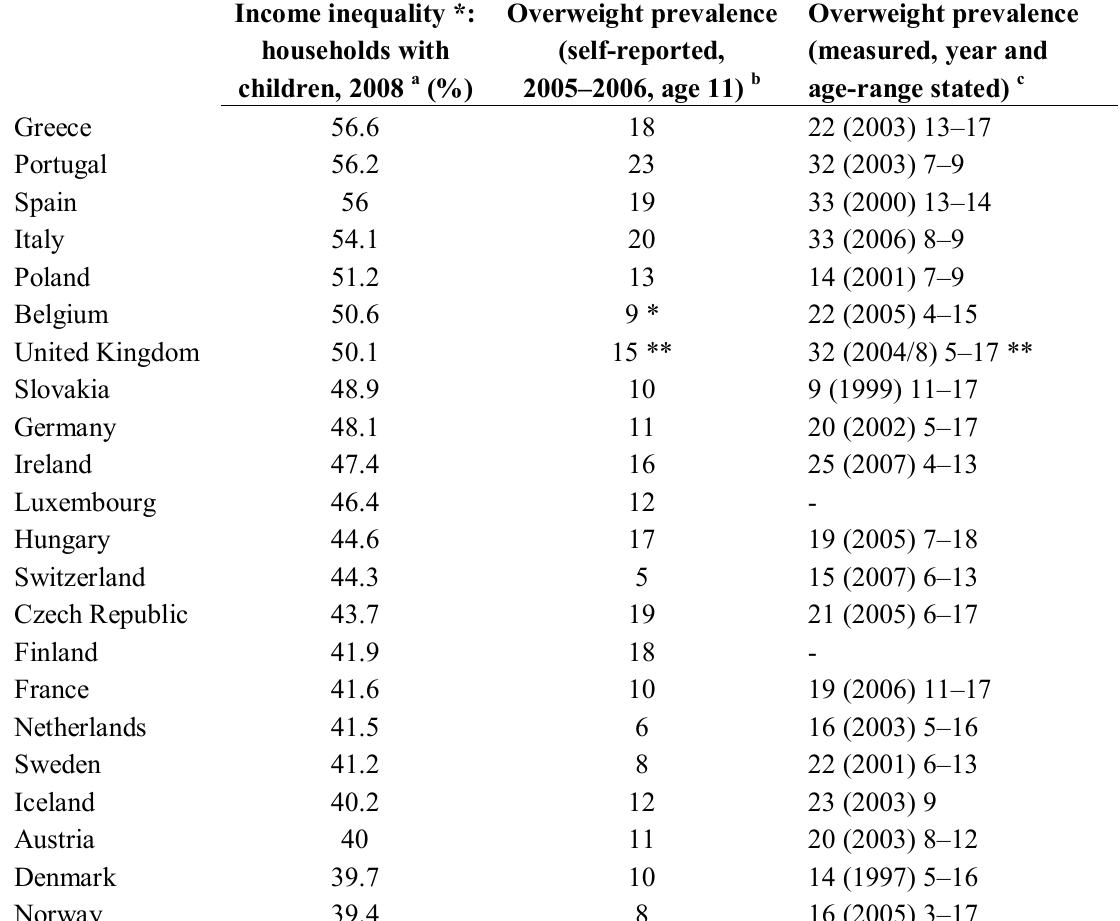
Table 1. Cross country measures of income inequality and child overweight prevalence (%) in 22 European countries, ordered by income